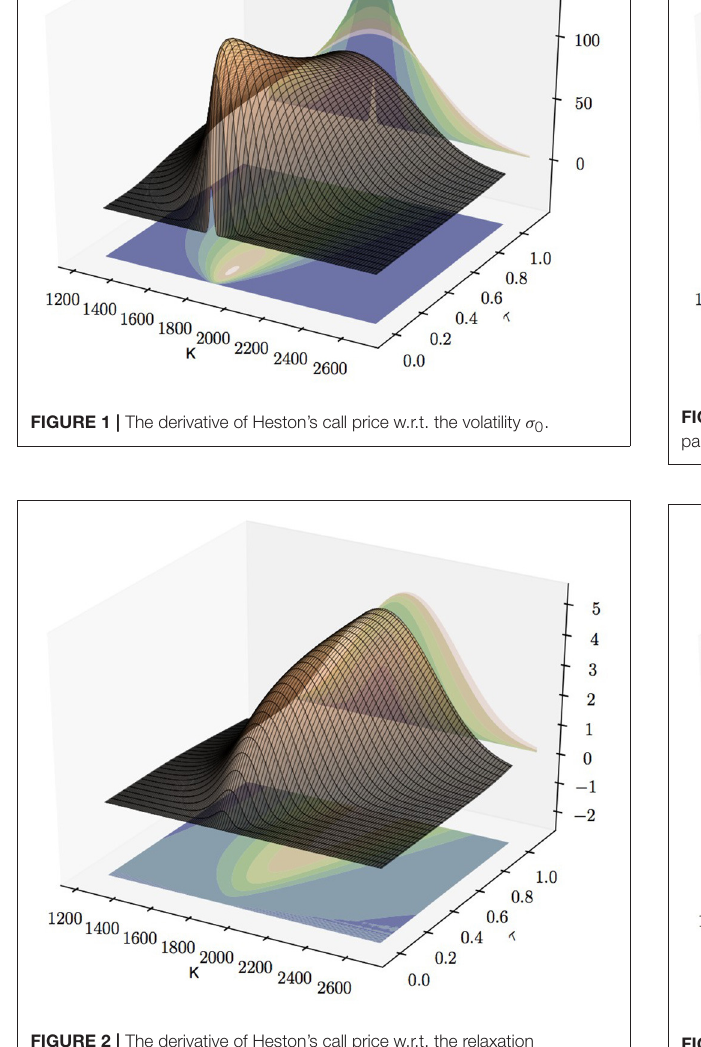
FIGURE 4 | The derivative of Heston’s call price w.r.t. the volatility of the variance process σ